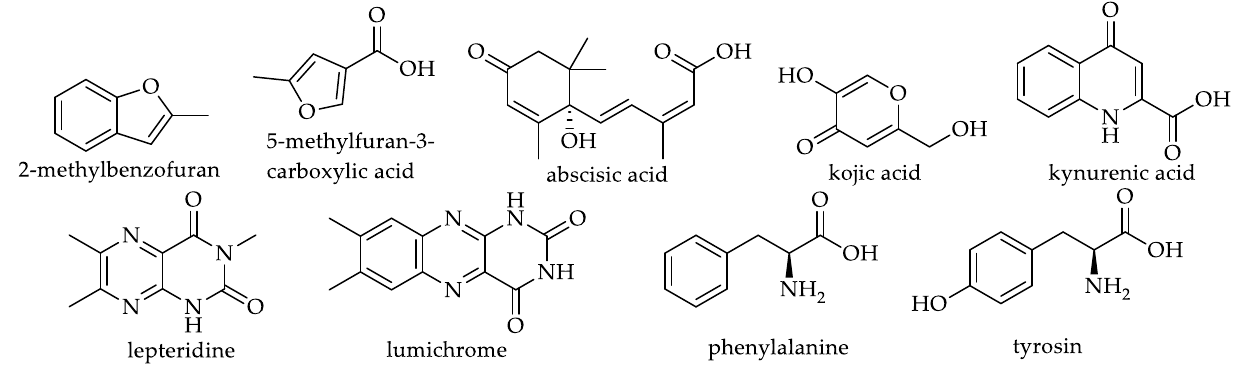
Figure 22. Structures of non-phenolic compounds (see 162 – 170 in Table 16). Table 16. Non-phenolic compounds reported in monofloral honeys. Table 16. Non-phenolic compounds reported in monofloral